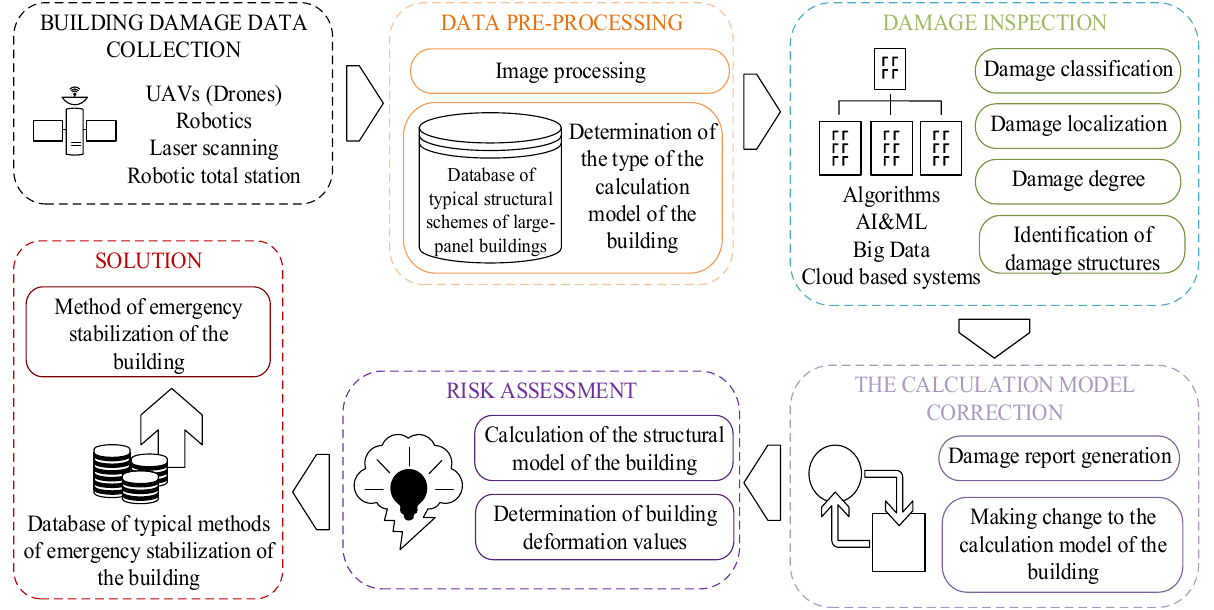
Figure 13. Proposed BIM-based workflow for the assessment of damaged large-panel buildings with identified processes that potentially could be automated.